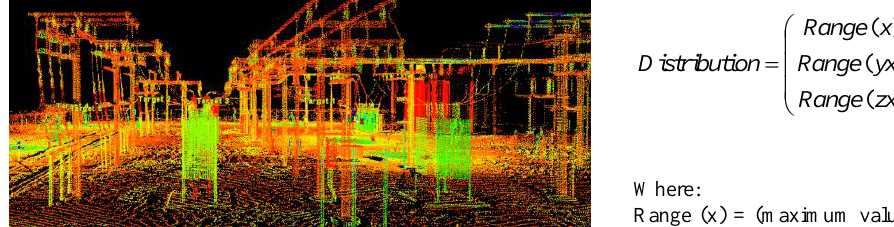
Figure 3. The repetitive pattern of objects